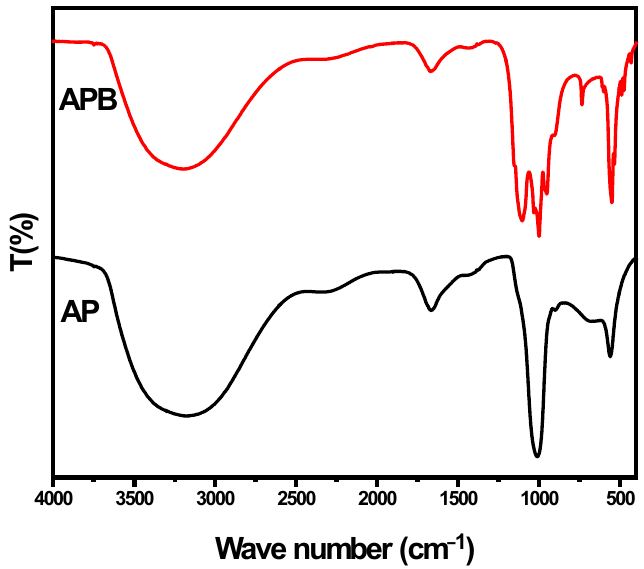
Figure 3. FT-IR spectra of pure Ag 3 PO 4 and BaO@Ag 3 PO 4 nanocomposite.